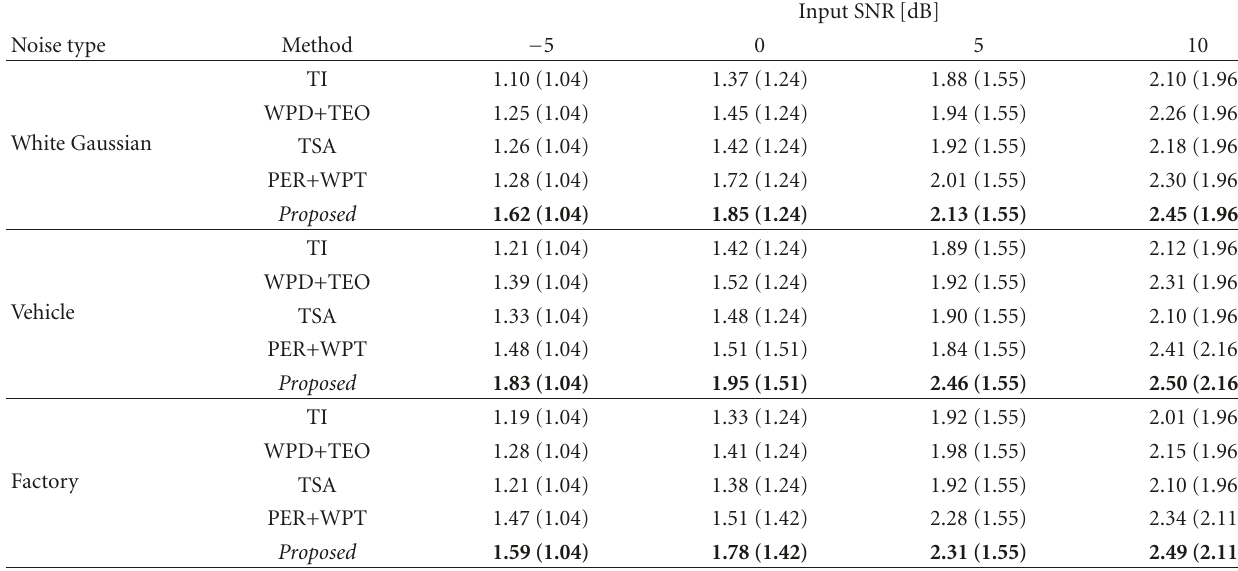
Table 3: The objective evaluation using PESQ